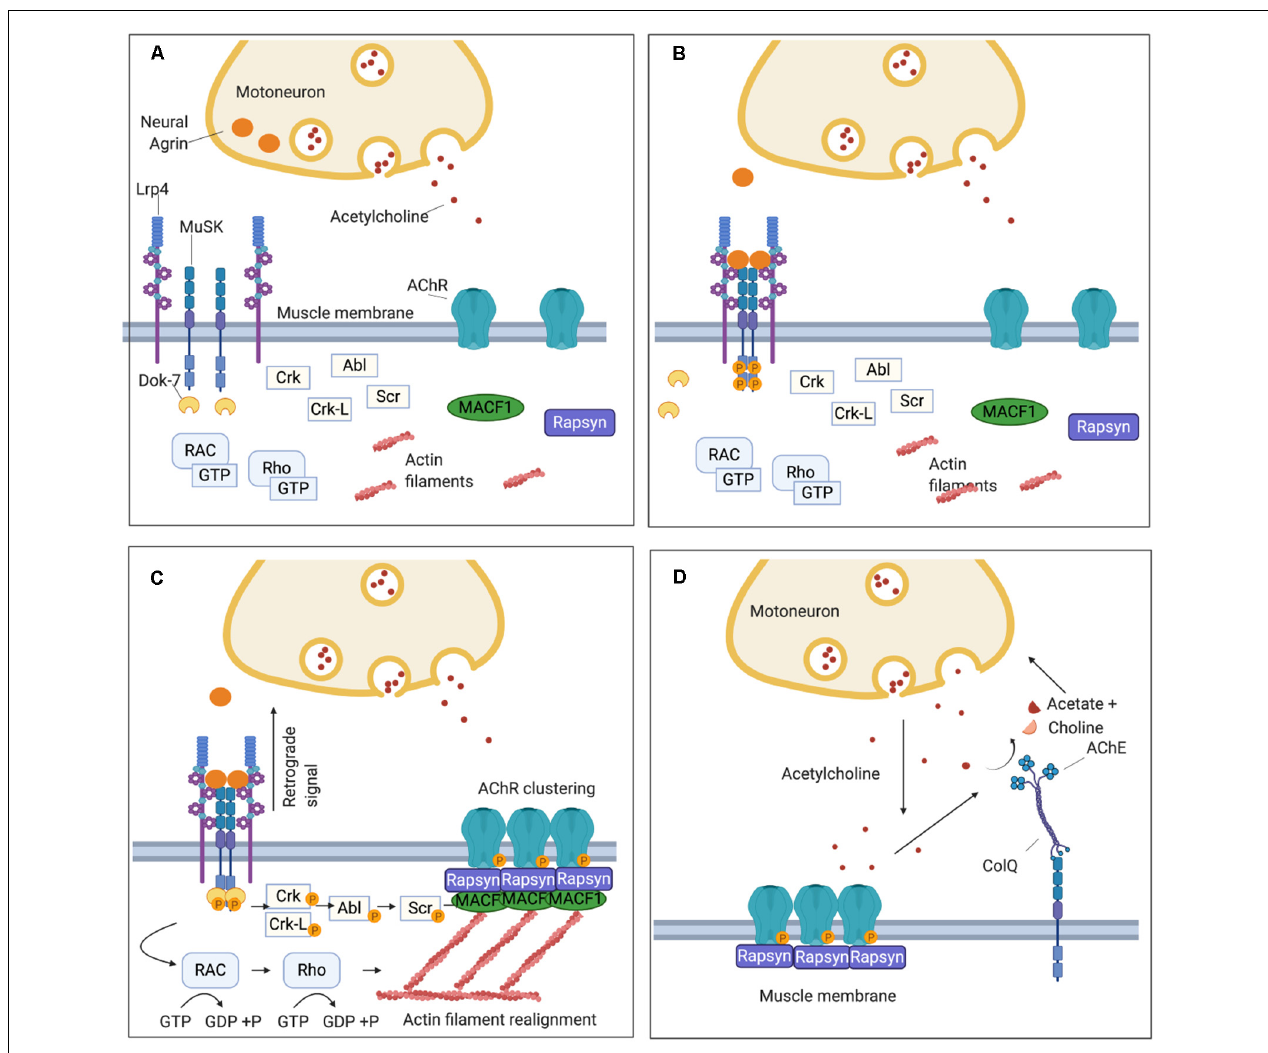
FIGURE 1 | Schematic representation of the neuromuscular junction (NMJ) and the clustering pathway of acetylcholine receptors (AChRs). (A) On the muscle post-synaptic membrane, low density lipoprotein receptor-related protein 4 (LRP4) and Muscle Specific Kinase (MuSK) form a loose tetramer, and, at this stage, AChRs are dispersed along the sarcolemma. (B) Agrin is secreted by the motor nerve terminal into the synaptic cleft and interacts with LRP4 inducing a conformational change in the LRP4-MuSK tetramer. This leads to MuSK activation through an auto-phosphorylation loop of the tyrosine residues in its intracytoplasmatic domain. (C) The recruitment of DOK7 amplifies MuSK phosphorylation and triggers the phosphorylation cascade downstream that involves several intermediate proteins including Crk, Ckr-l, Abl, and Scr. Concomitantly, a subsidiary pathway leads to cytoskeletal rearrangements through the activation of Rac1 and Rho GTPases. The clustering pathway culminates in the phosphorylation of the subunits of the AChR and the recruitment of rapsyn, which anchors the AChR clusters to the underlying actin filaments. Furthermore, LRP4 participates in presynaptic development through a retrograde signal which increases the clustering of ACh vesicles in the motor nerve terminal. (D) Via the extracellular matrix (ECM), MuSK interacts also with ColQ which, in turn, is attached in tetramers to the enzyme acetylcholinesterase (AChE) responsible for the hydrolysis of acetylcholine (ACh) after its binding to the